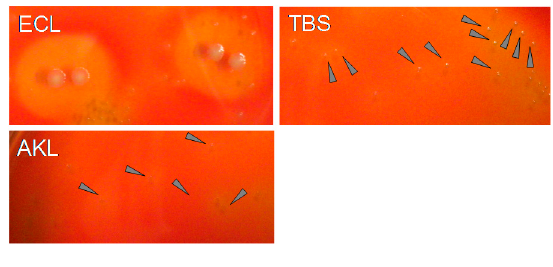
Figure 7. Stimulatory and inhibitory effects of ECA and AKL on growth of S. pyogenes . Culture media containing ECA, AKL, or TBS (as in Figure 6) were diluted 10-fold with saline. Each of the three media (100 μL) was spread on agar plates containing 5% rabbit RBCs and incubated for 18 h. Arrows indicate